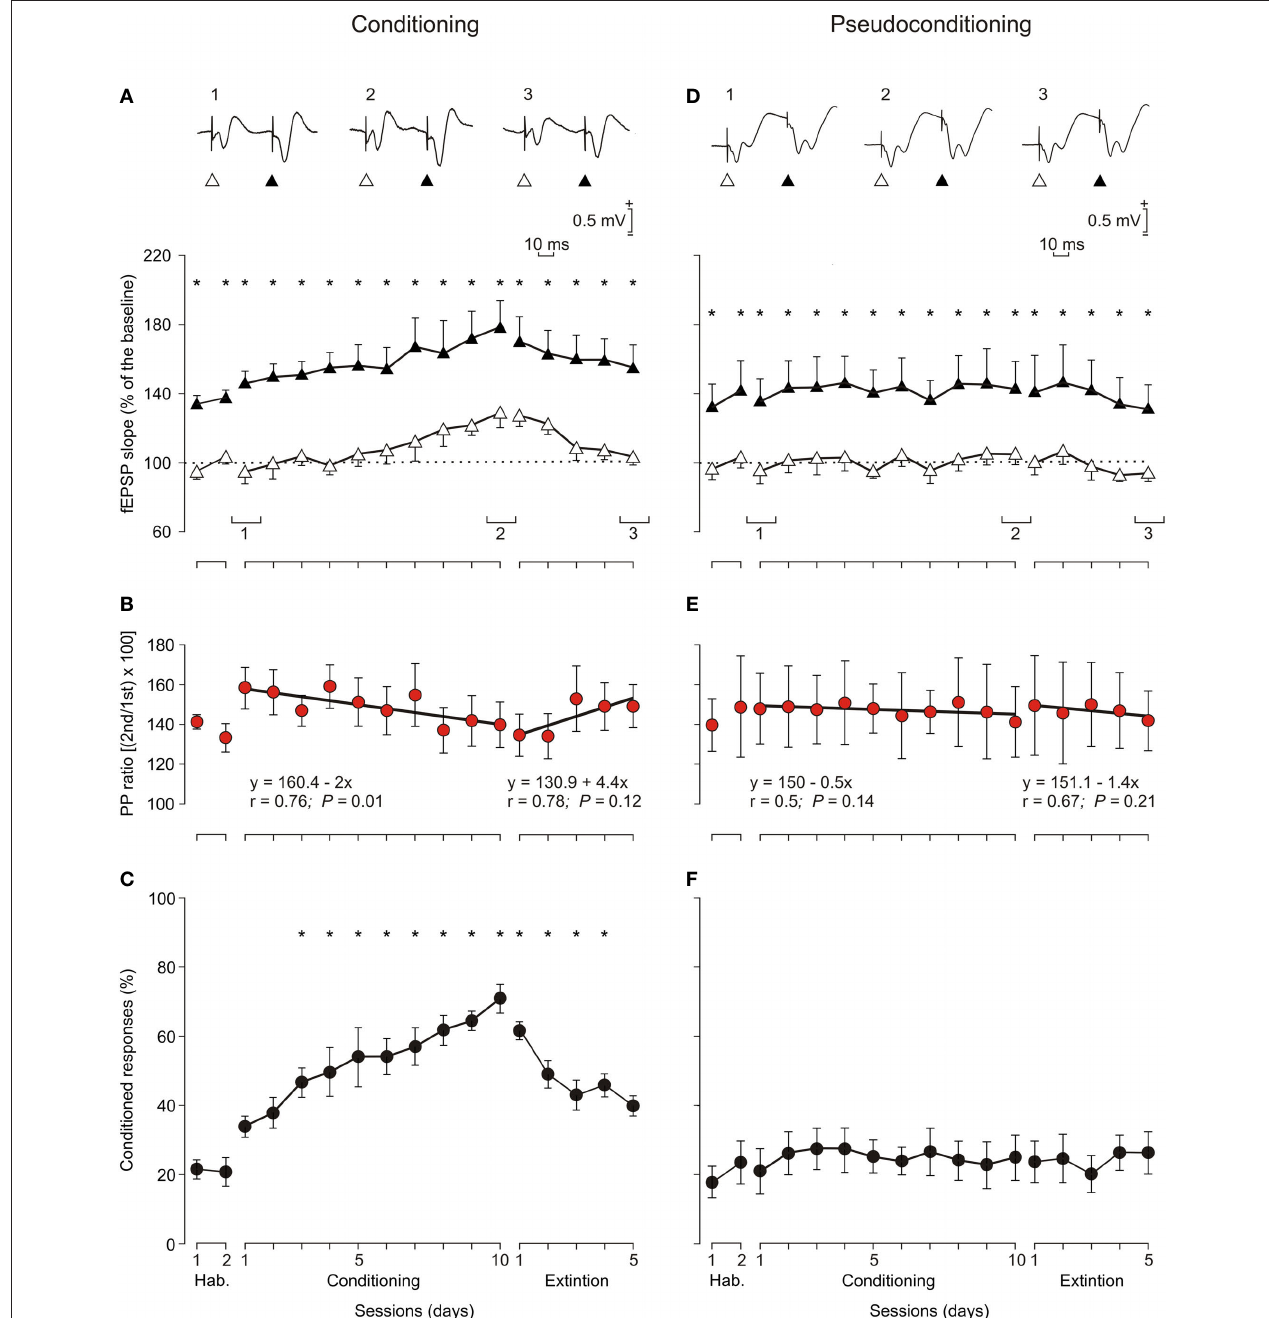
FIGURE 7 | Learning curves and evolution of fEPSPs evoked by paired- pulse stimulation across the classical conditioning of eyelid responses. (A) Evolution of fEPSPs evoked in the CA1 area by a pair of pulses (1st, white triangles; 2nd, black triangles) at 40 ms interval presented to Schaffer collaterals 300 ms after CS presentation. Illustrated data correspond to mean ± SEM. * P < 0.001, [F = 41.443] for signifi cant differences between the 1st and the (16,144) 2nd pulses. At the top are illustrated some representative examples (averaged three times) of fEPSPs evoked at the CA3-CA1 synapse by paired-pulse stimulation (40 ms interval) collected during the 1st (1) and 10th (2) conditioning sessions and during the 5th (3) extinction session from a conditioned animal. (B) Note that although fEPSPs slopes increased across conditioning and